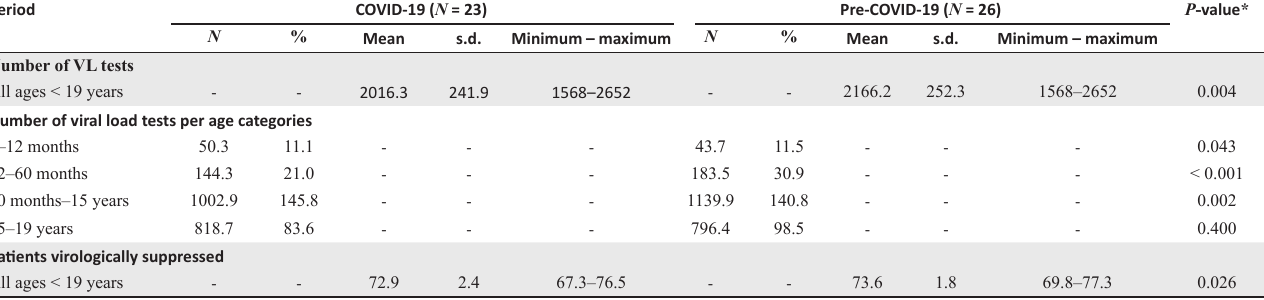
TABLE 1: Comparison of viral loads done and percentage of patients virologically suppressed over the study period. Period